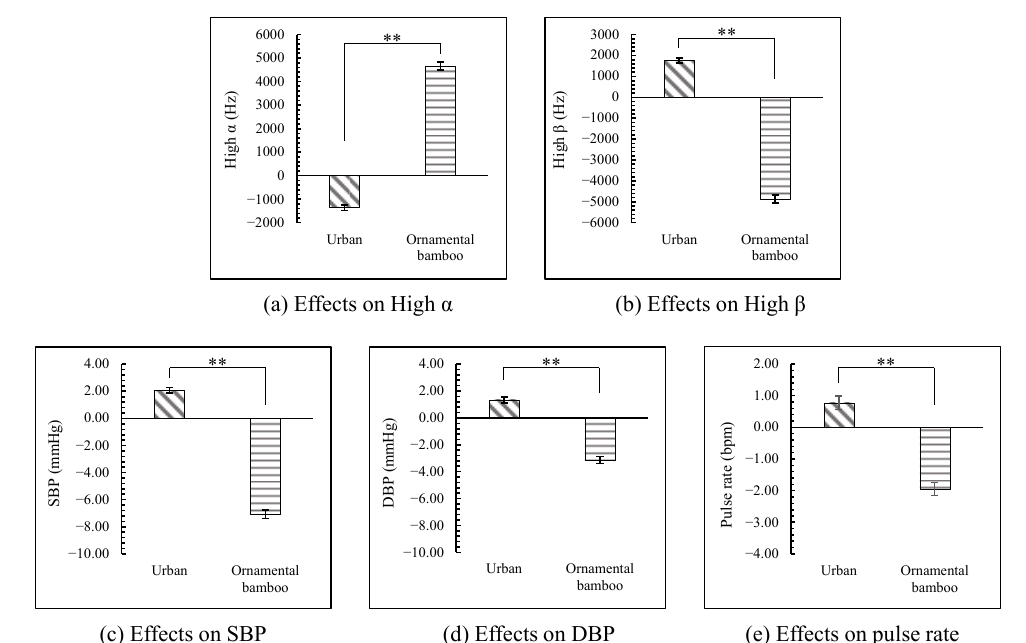
Figure 3. Comparison of physiological indicators after the participants viewed the stimulus images between urban and ornamental bamboo groups. The zero point represents the value measured after participants having a rest. SBP: systolic blood pressure; DBP: diastolic blood pressure; n = 300; mean ± SD; ** p < 0.01.